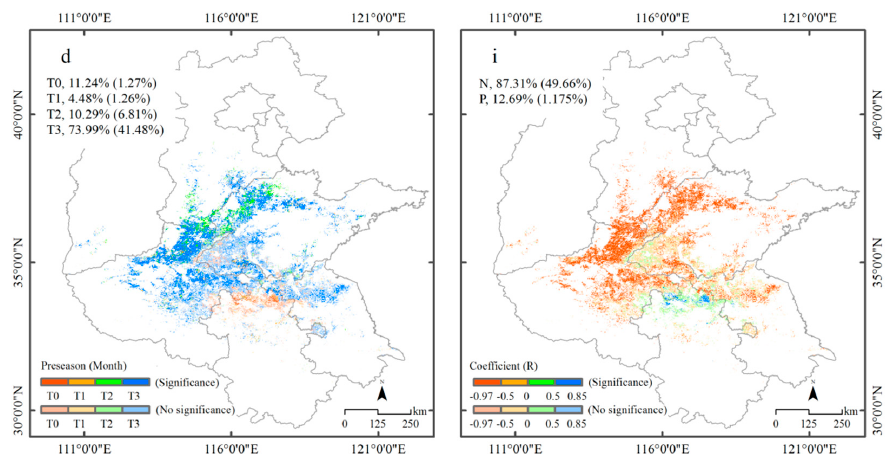
Figure 10. GUD time lag responses to T m , TP , T min , T max ( a – d ) and its relationship ( e – i ), respectively. Areas with no statistical significance ( P < 0.05) are depicted in the corresponding color with 60% transparency. The texts in the upper left corner of each left figure present the percentage of lag time (T0, T1, T2, and T3) (P < 0.05, percentage of significant lag time in parentheses). The texts in the upper left corner of each right figure present the percentage of positive (P) and negative (N) correlations (P < 0.05, percentage of significant correlations in parentheses).